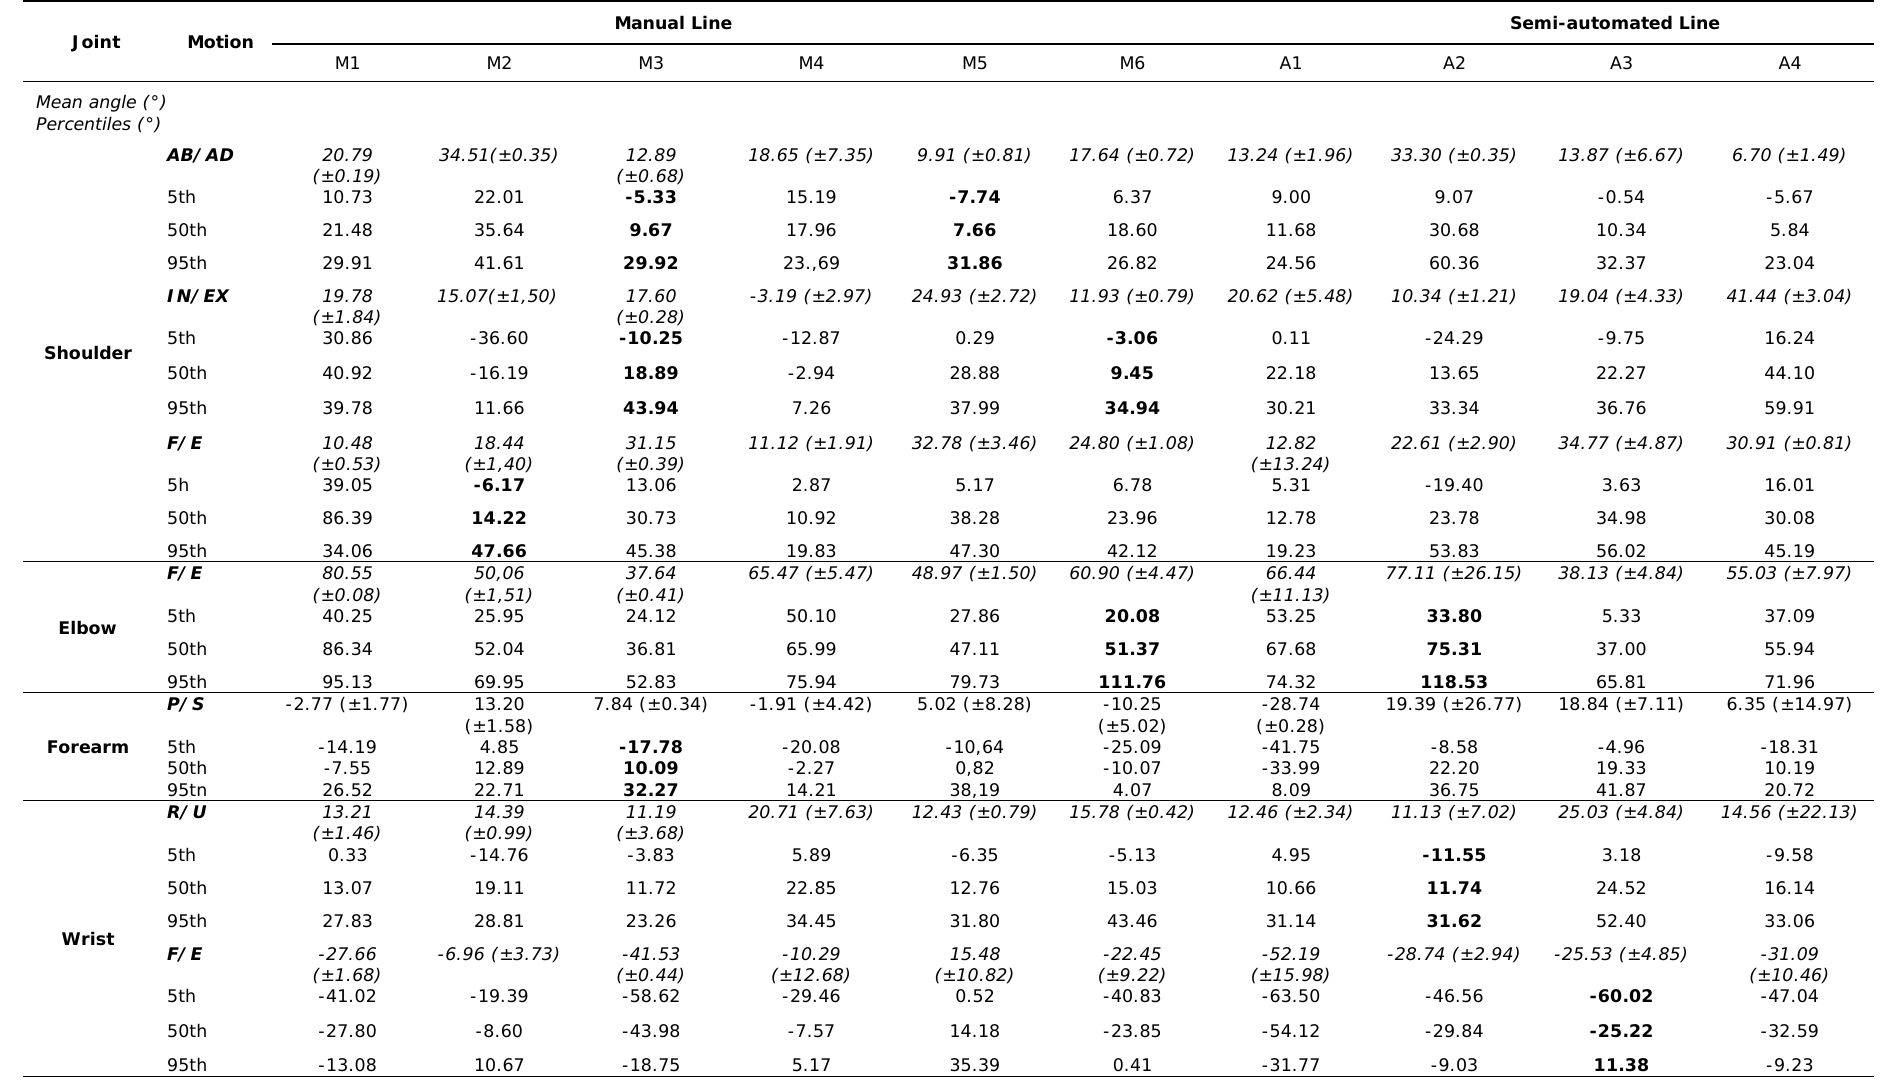
Table 3. Mean (SD) and percentiles of joint angles. Flexion, abduction, ulnar wrist deviation, pronation and internal rotation are positive (+); extension, adduction, radial wrist deviation, supination and external rotation are negative (-)